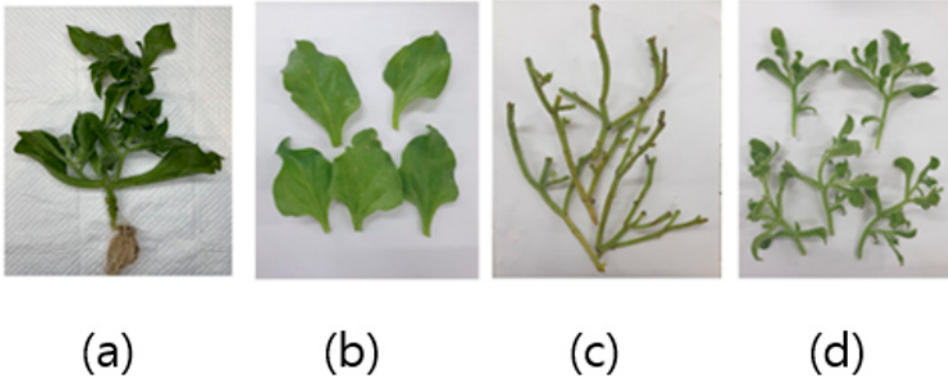
Figure 1. Photographs of the ice plant ( Mesembryanthemum crystallinum ) to characterize the properties of biochemical function and contents: ( a ) whole plant, ( b ) coleoptile, ( c ) stem, and ( d ) leaf. The leaf and stem are separated into apex and basal parts.